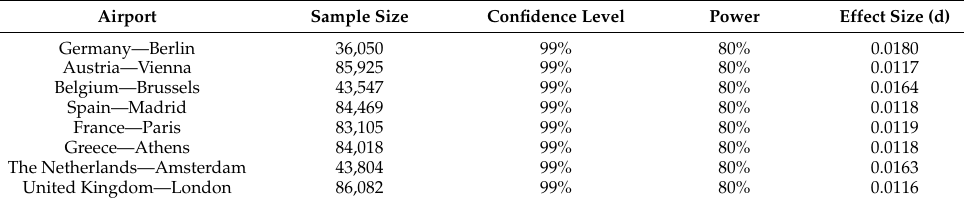
Table 4. Sample size veri fi cation.